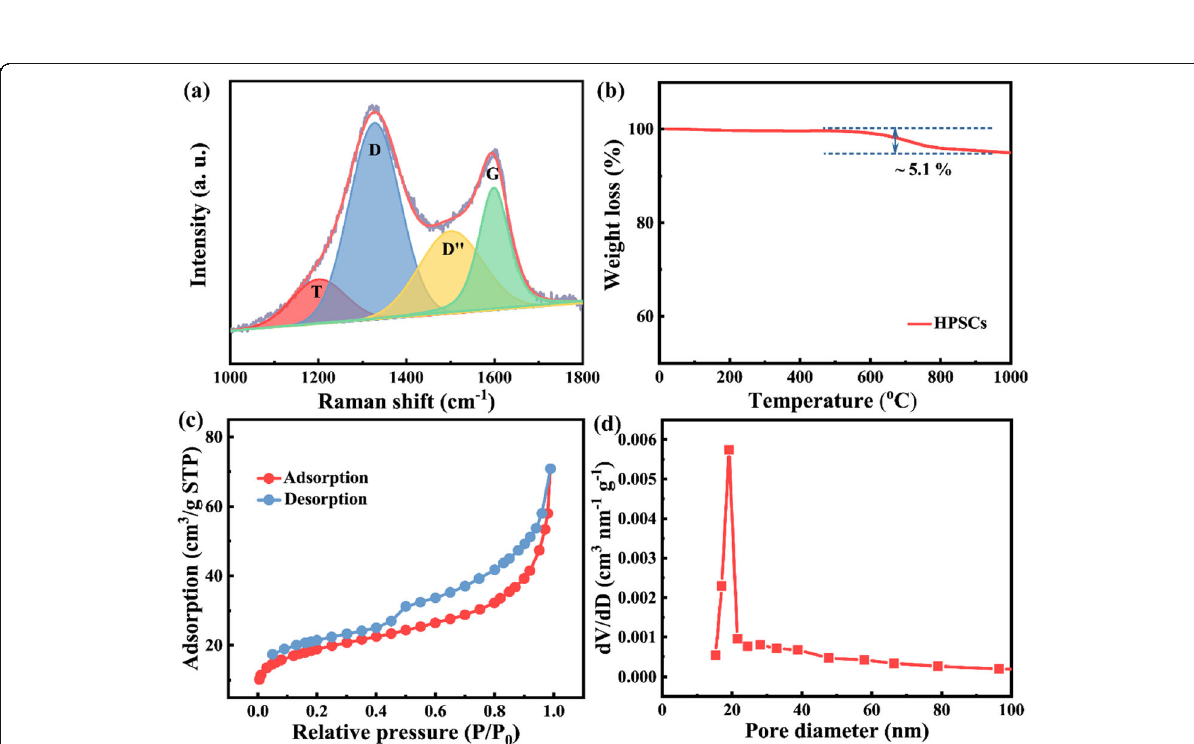
Fig. 4 a The Raman spectrum. b TGA curve under air atmosphere. c N 2 adsorption – desorption curves. d Pore size distribution of HPSC